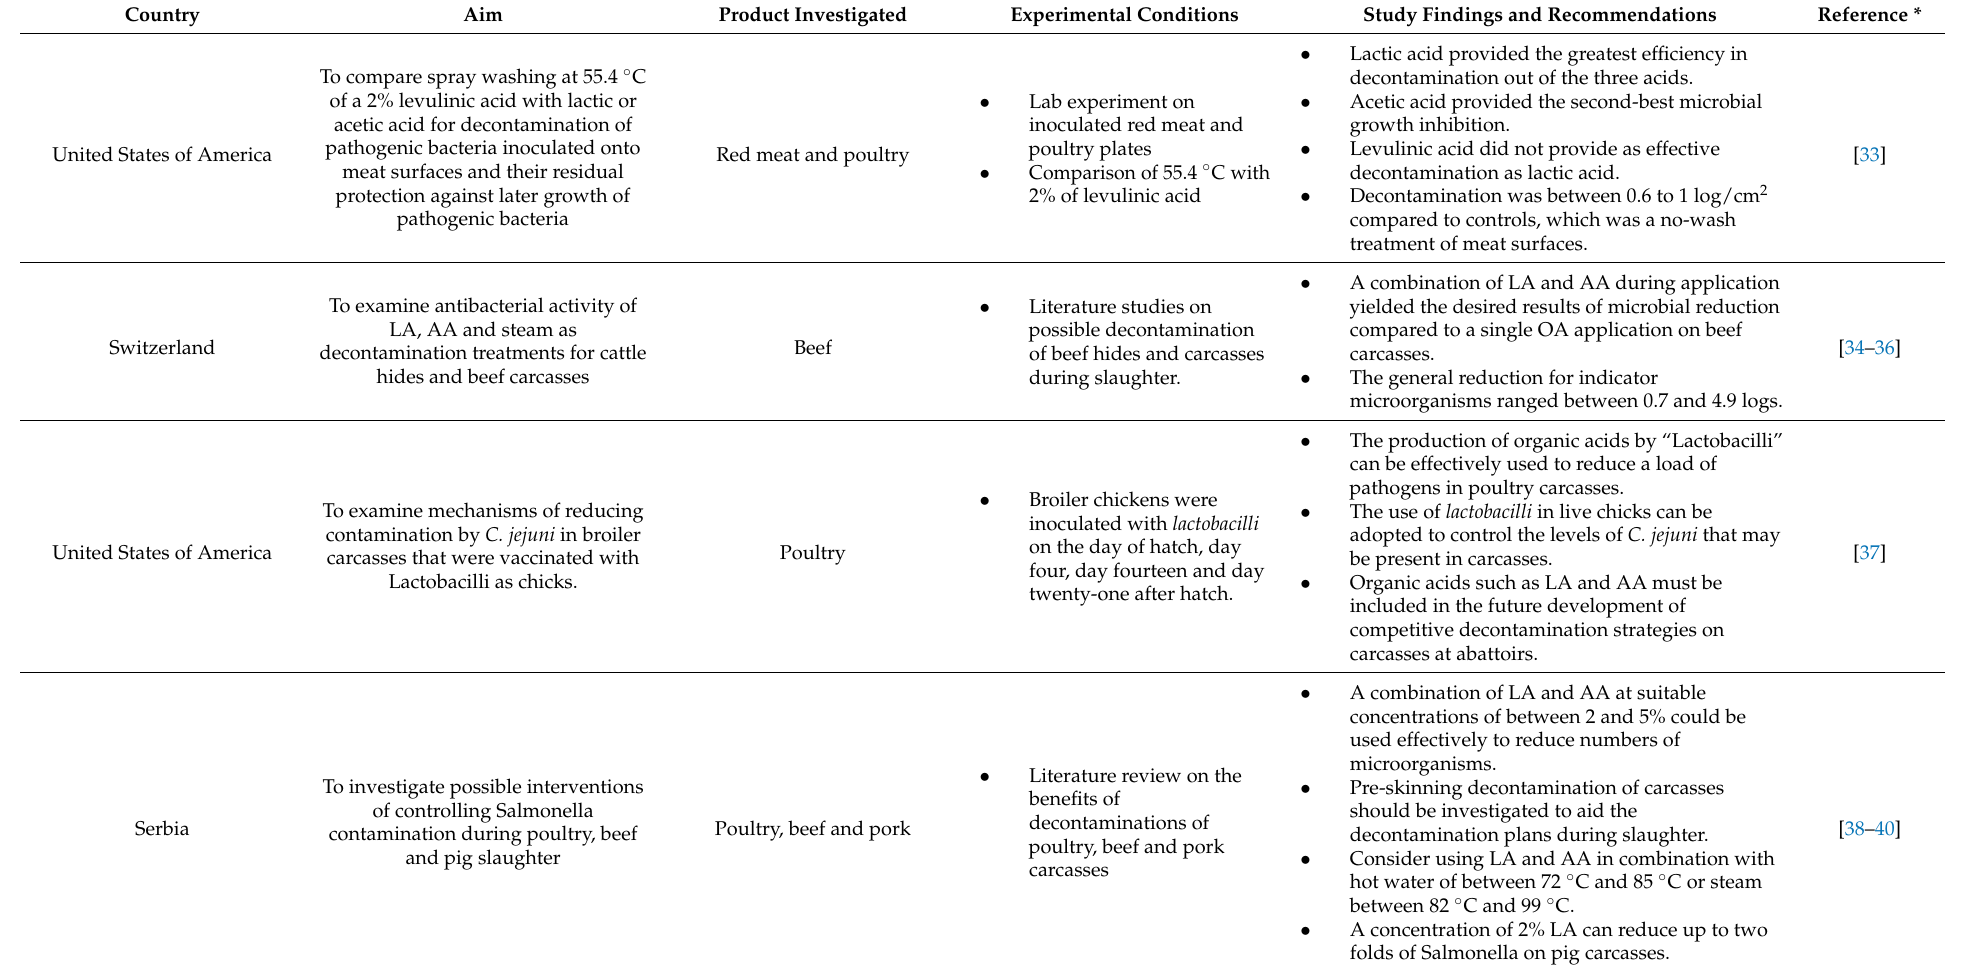
Table 1. Summary of the use of acetic and lactic acid to decontaminate carcasses derived from research (2011–2021). The order of presentation in ascending order of publication date.